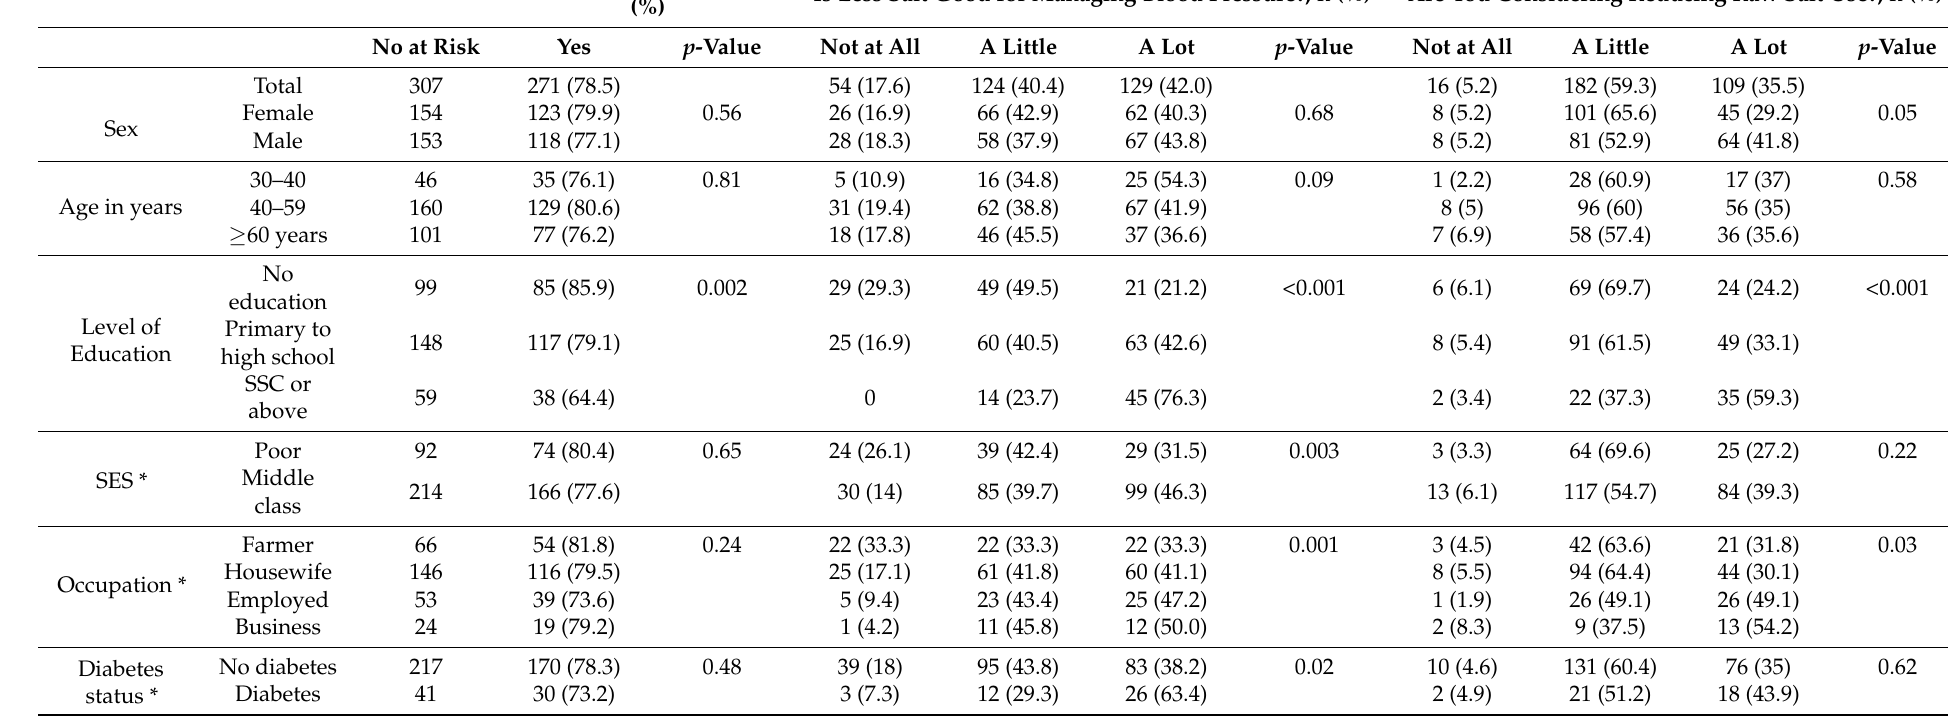
Table 2. Raw salt consumption habits, and knowledge and attitudes towards raw salt consumption and their associated